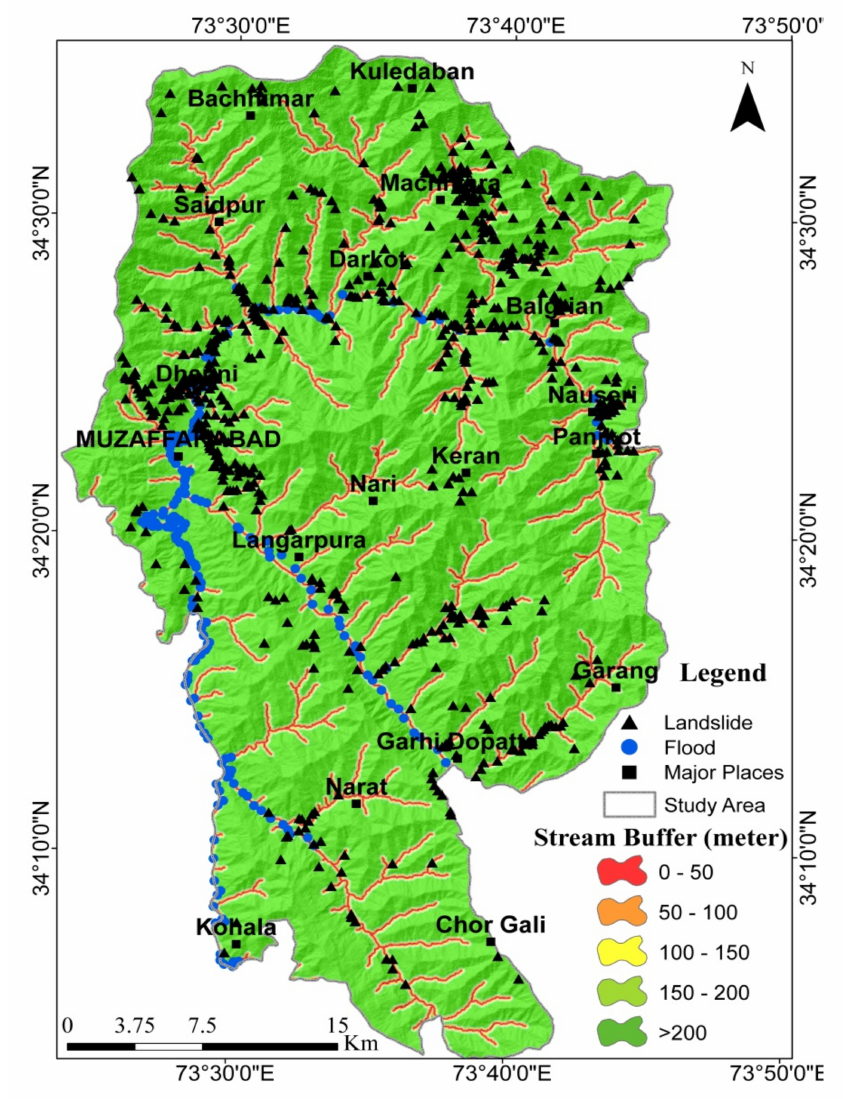
Figure 5. Hydrology causative factor map. Table 6. AHP matrices and OWs for the hydrology causative factor